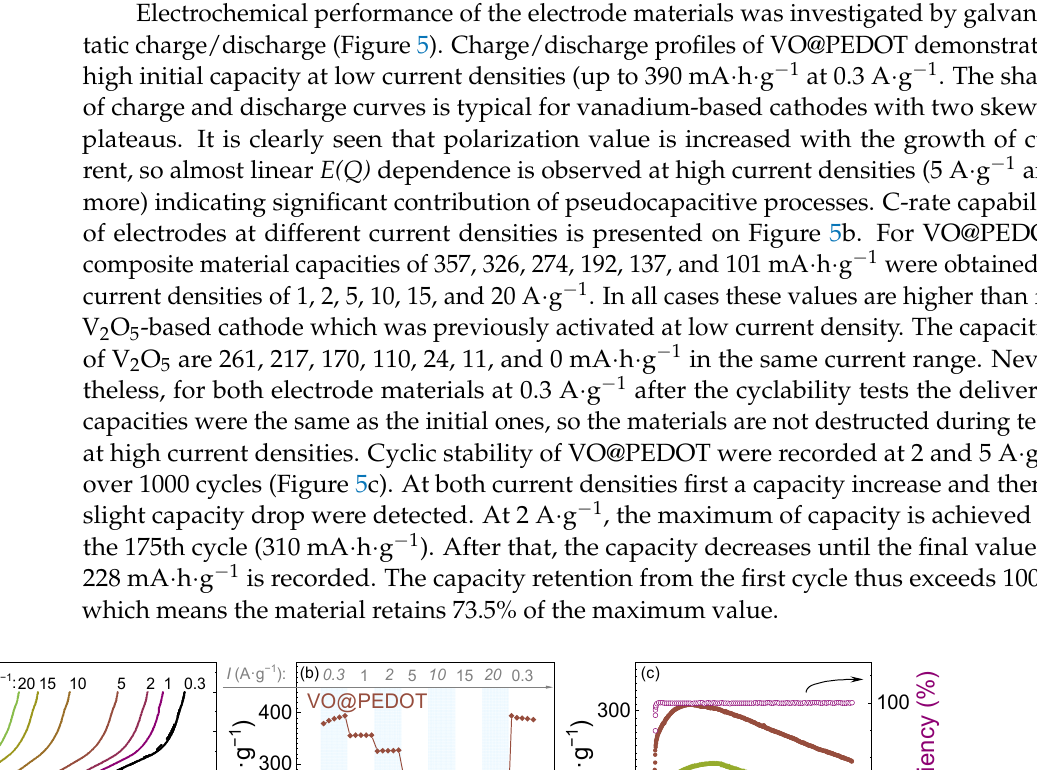
Figure 6. The comparison of the VO@PEDOT cathode with other V 2 O 5 -based cathodes for Zn-ion batteries [19,42,63–71]. To estimate the contribution of diffusion-controlled and capacitive-controlled cur- rents into the total measured currents, we performed CV measurements in the 0.3–1.4 V range at the scan rates from 0.1 mV ∙ s − 1 to 1 mV ∙ s − 1 (Figure 7a). The shape of the CVs at various scan rates is similar for VO@PEDOT electrodes with slight potential shifting. The dependence of the peak current ( i ) on the scan rate ( v ) can be represented via (1): 𝑖 = 𝑎 ∙ 𝑣 (cid:3029)